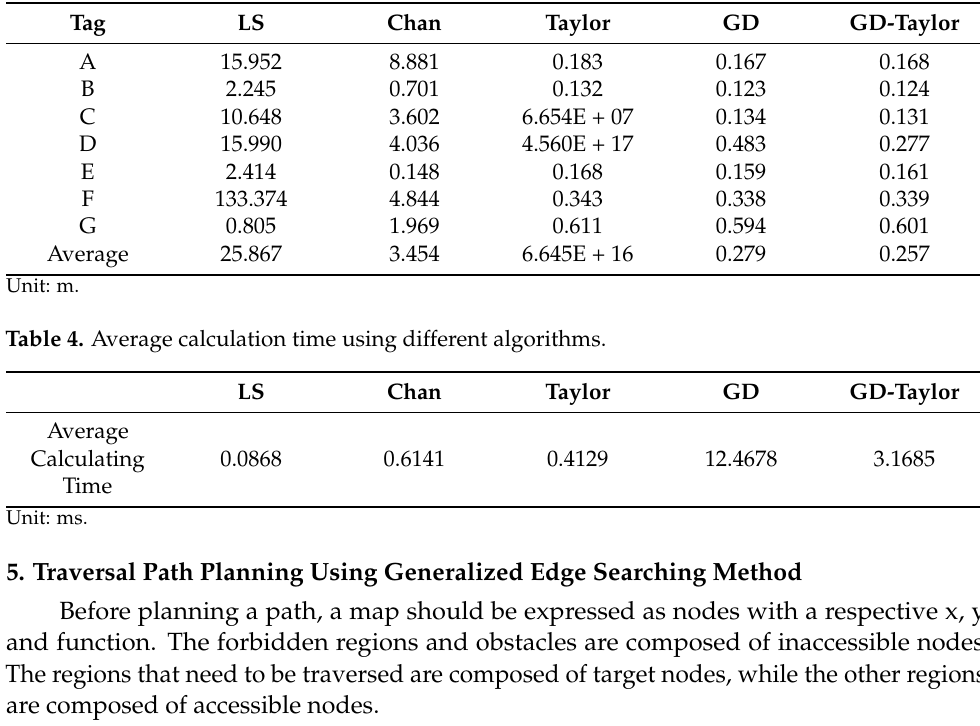
Table 3. RMSEs of Tag positions using different algorithms in measurement.